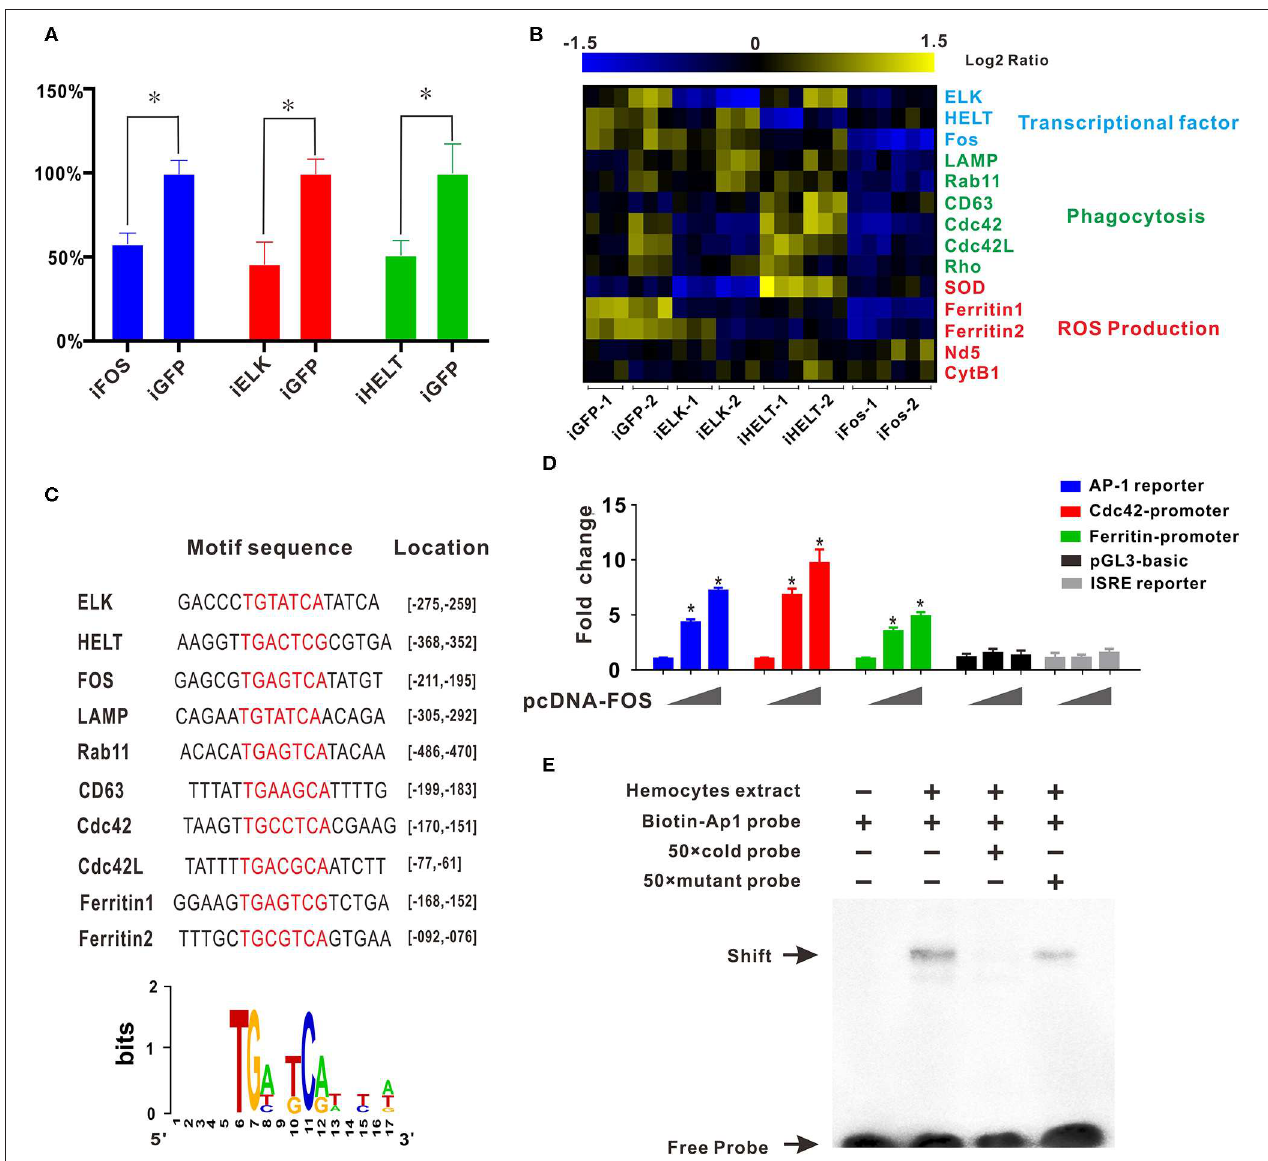
FIGURE 4 | Transcription factor Fos regulates transcriptional activation of granulocyte-specific genes. (A) Inhibition rate of RNA interference of three transcription factors (Fos, ELK, and HELT) in vivo . Blue panel , interference of Fos; red panel , interference of ELK; green panel , interference of HELT. (B) mRNA expression levels of immunity-related genes after knockdown of three transcription factors (ELK, HELT, and Fos). Detected genes were classified into three groups based on their potential functions: transcription factors, phagocytosis, and ROS production. Colors from yellow to blue indicate range of log 2 ratio values (in descending order); yellow color indicates high expression level and blue color indicates low expression level. (C) Transcription factor binding site prediction software identified an AP-1 site that was highlighted in promoter element sequence of some immunity-related genes. Specific nucleotides were marked with red color. (D) Relative luciferase activity by expression of Fos plasmid for the luciferase reporter genes, AP-1 reporter Luc ( blue panel ), Cdc42 promoter reporter Luc ( red panel ), Cdc42l promoter reporter Luc ( green panel ), pGL3-basic vector ( black panel ), and ISRE-luc reporter ( gray panel ) in HEK293T cells. Plasmid pcDNA-Fos were added in gradient concentration (0, 150, and 300 ng). * p < 0.05. (E) AP-1 probe was labeled with biotin and incubated with C. gigas -extracted hemocyte proteins. Unlabeled specific competitor sequences (cold probe) were used in a 50-fold surplus over labeled